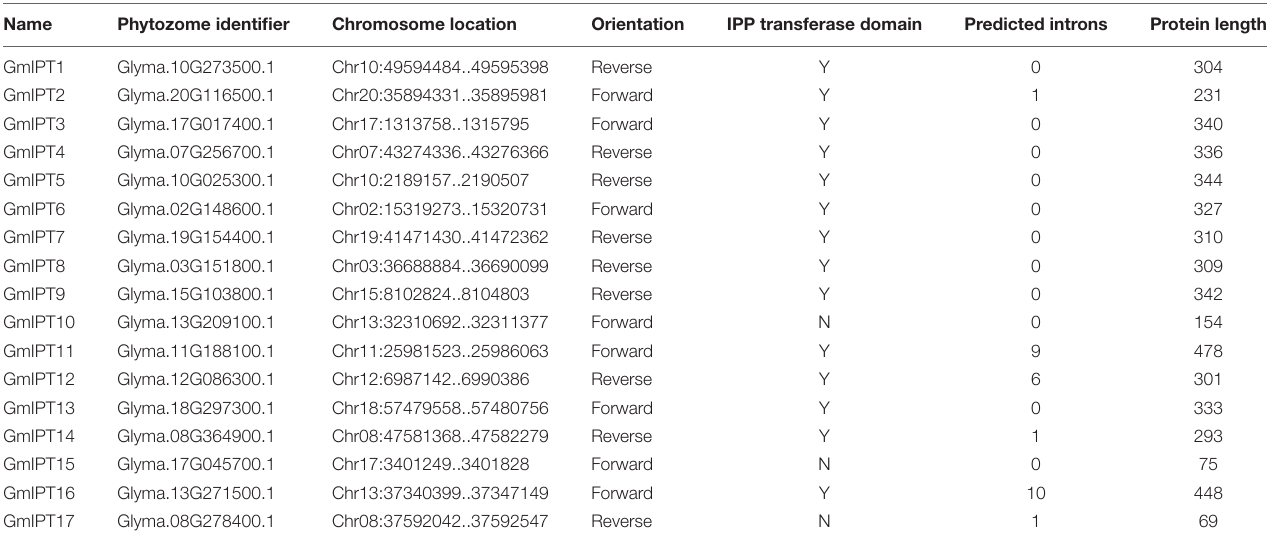
TABLE 1 | Features of the IPT gene family in